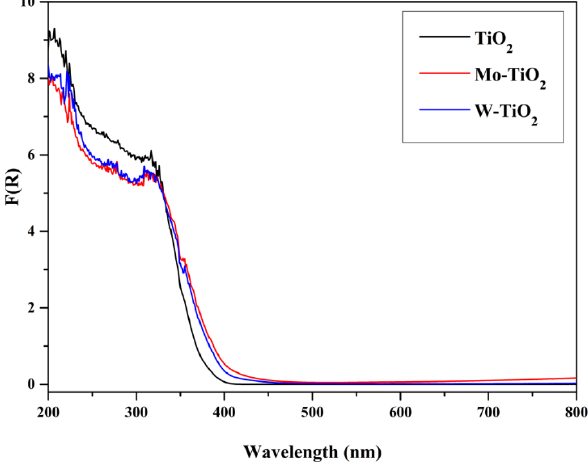
Figure 13. DR spectra of TiO 2 , Mo ‐ TiO 2 , and W ‐ TiO 2 .